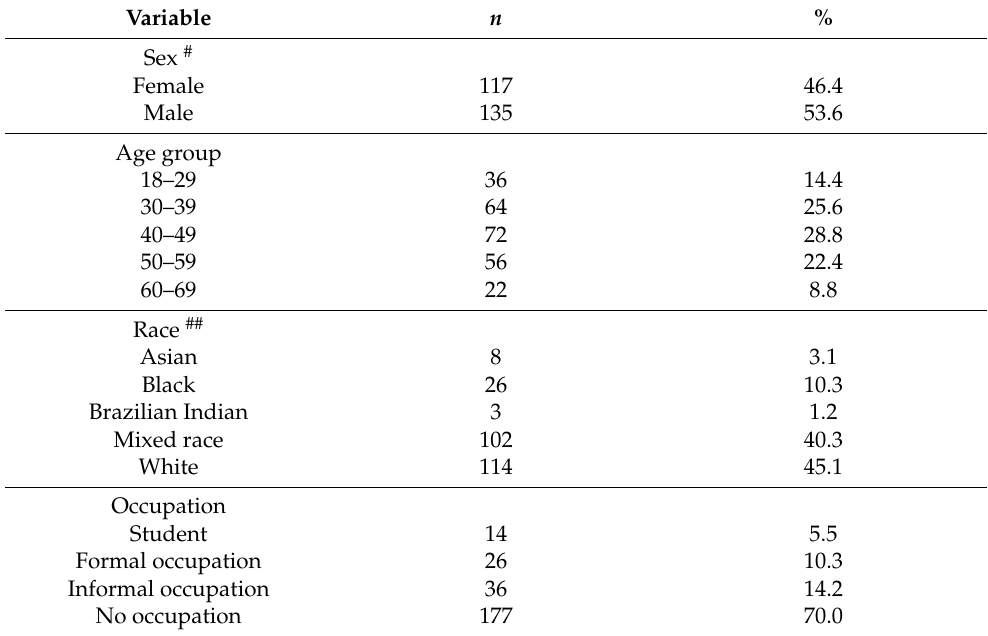
Table 1. Sociodemographic and clinical characteristics of participants in Step 6, full psychometric testing ( n =